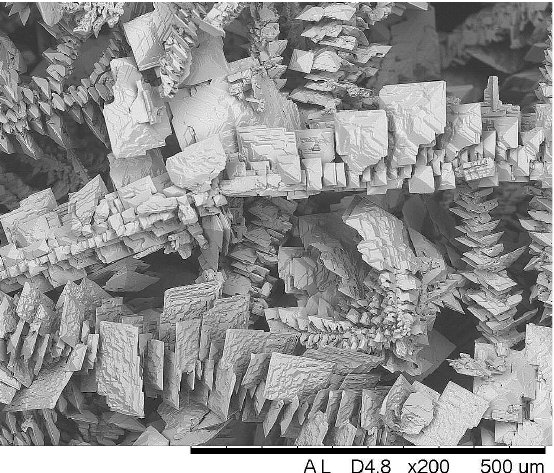
Figure 6. SEM image of Sn electrodeposit obtained at E = − 0.85 V and 60 °C from the solution “Ref”.